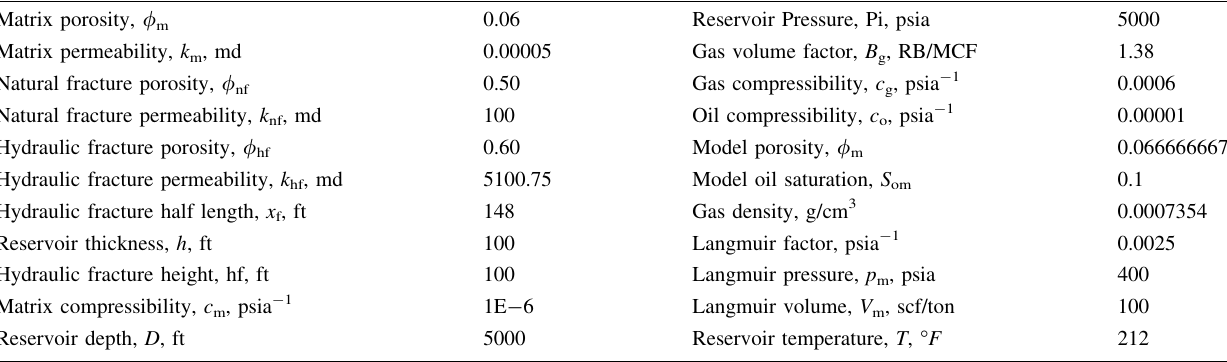
Table 1 Values of parameters in shale gas simulation